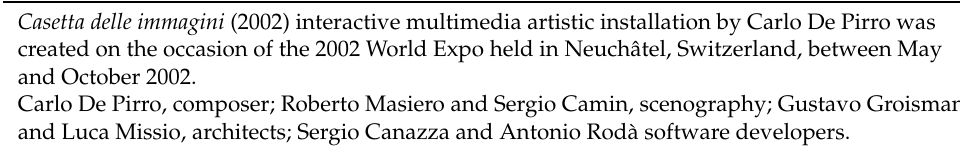
Figure 20. Guarnieri’s manuscript (first draft) with the arrangement of musicians and electronics at the PalaFenice ( left ). Diagram of the information flow from the player’s gesture to the expressive spatial diffusion of the sound ( right ). Table 4. Carlo De Pirro: Casetta delle immagini